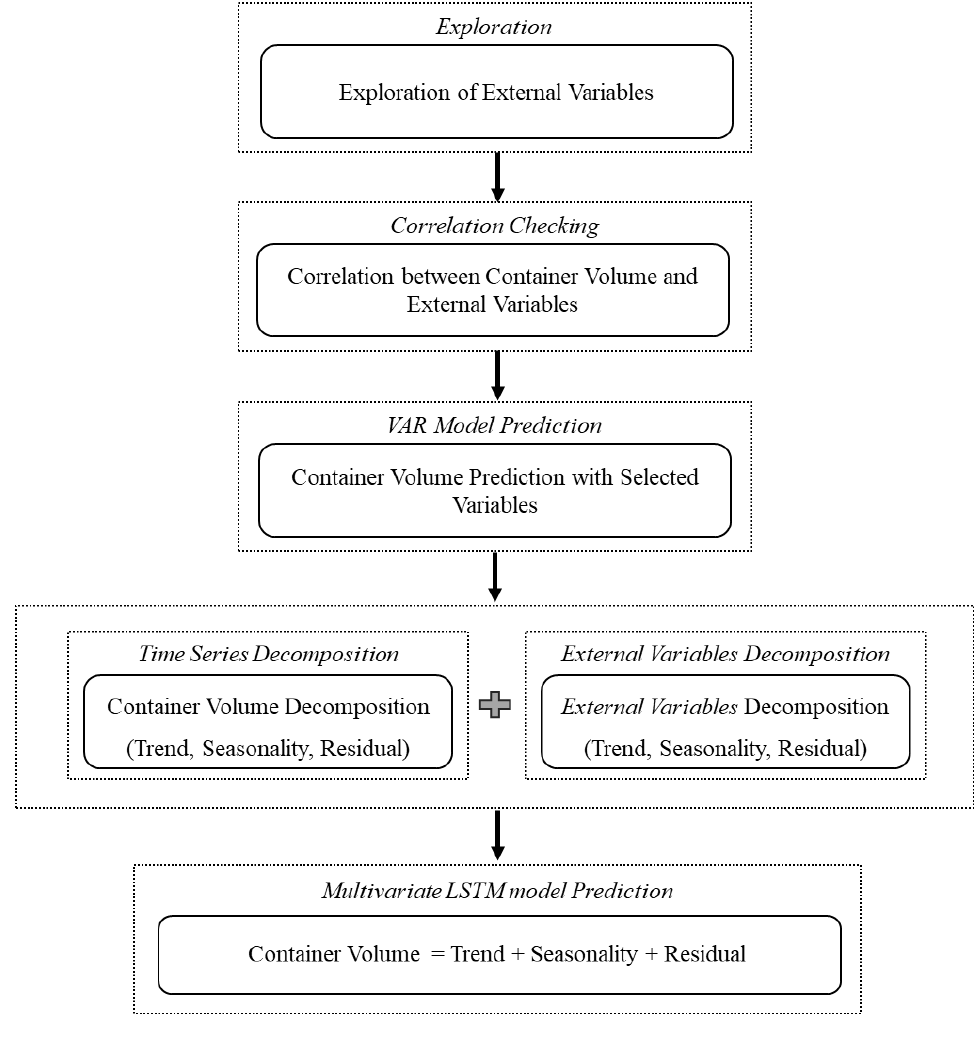
Figure 4. Flowchart of proposed method.